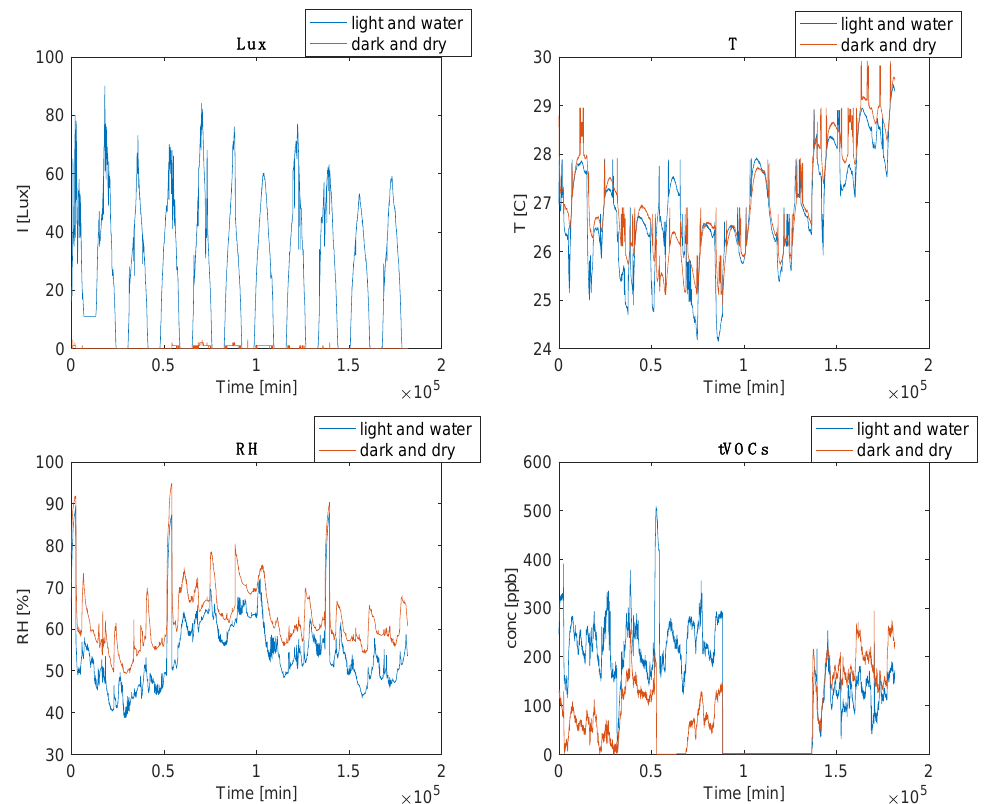
Sensors 2019 , 19 , x FOR PEER REVIEW